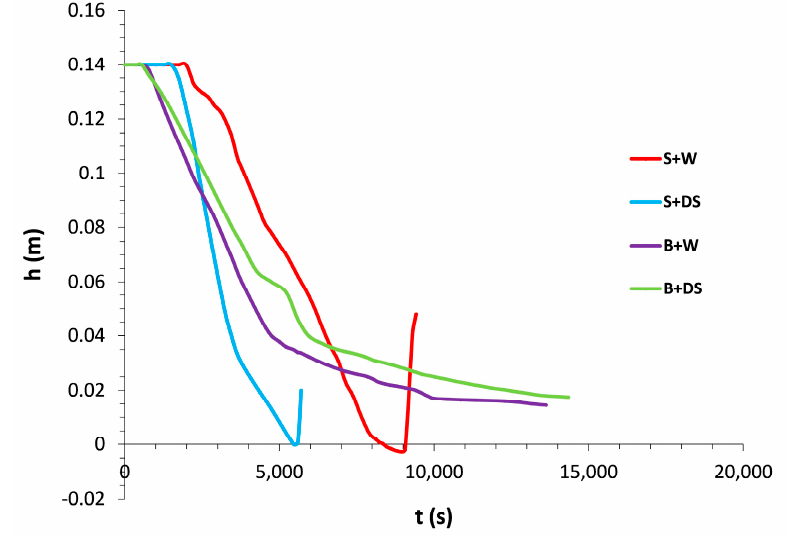
Figure 13. Thickness of the saturated layer.